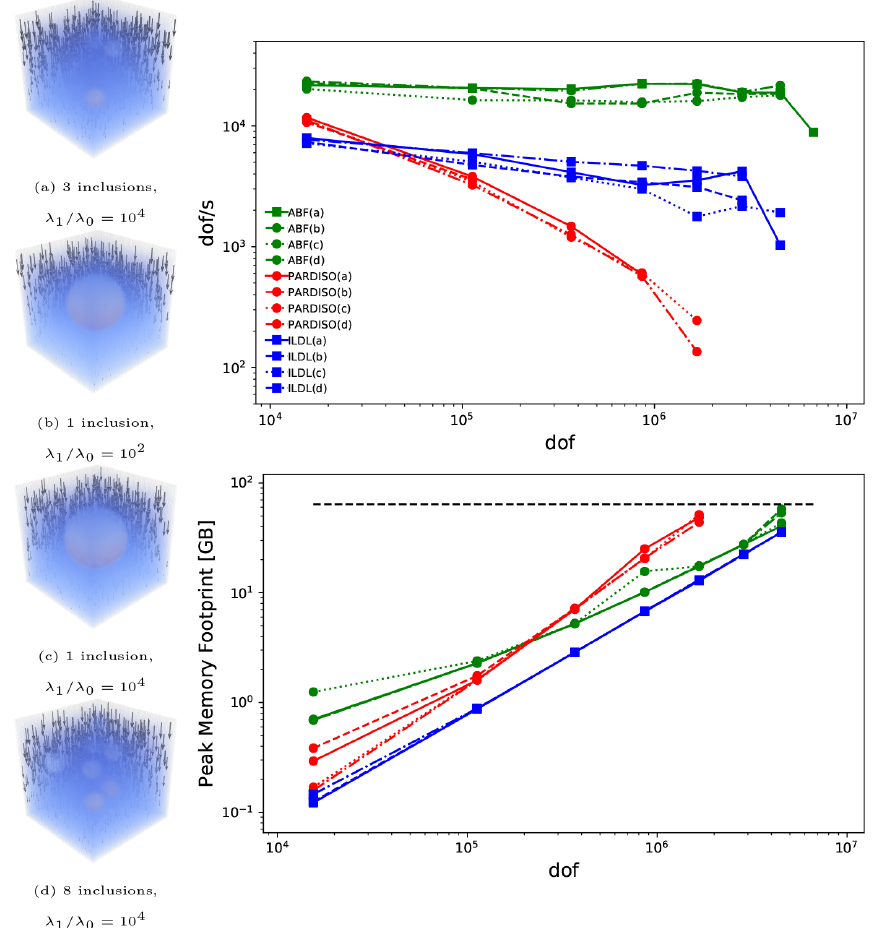
Figure 3. Experiments showing performance of ILDL preconditioning for the elasticity system, holding µ 0 = µ 1 = 1, λ 0 = 1 constant and varying λ 1 inside inclusions of radius 0 . 25 (single inclusions) or 0 . 1. Arrows show displacement, and the pressure field is plotted